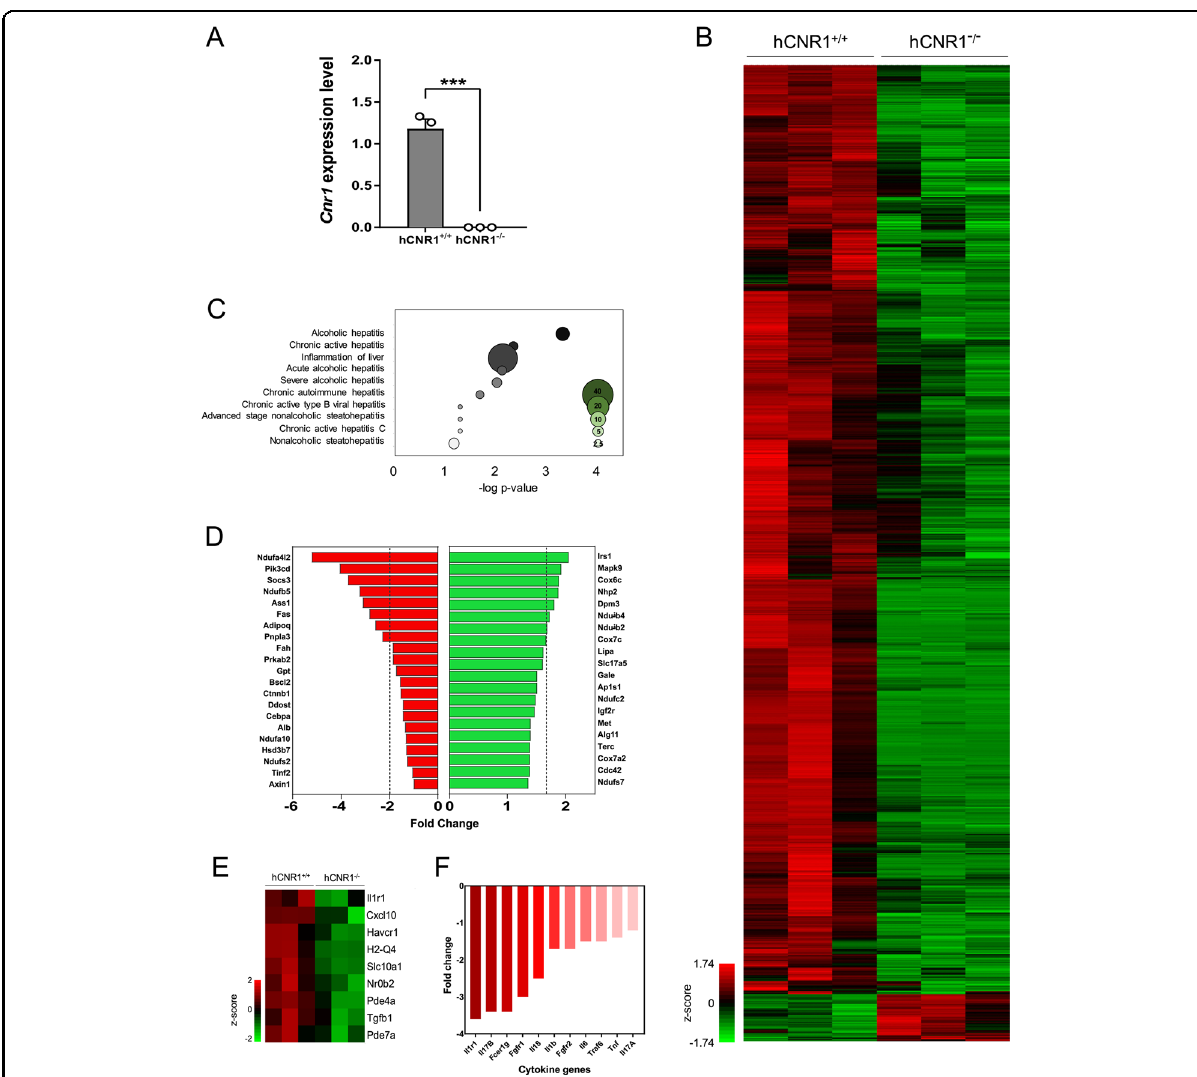
Fig. 1 Hepatic Cnr1 regulates liver disease-associated genes. Gene expression using RNA extracted from isolated hepatocytes of hCNR1 + / + and hCNR1 − / − mice ( n = 3). A CB1R mRNA ( Cnr1 ) expression in hepatocytes isolated from hCNR1 + / + and hCNR1 − / − mice. B Heat map of genome-wide expression changes by normalized z -score between − 1.74 and 1.74. C Gene ontology (GO) analysis on liver disease-related genes based on genome- wide expression changes by normalized z -score between − 1.74 and 1.74 depicted in B . Bubble sizes depict number of genes associated with hepatitis category. D Fold change of genes that are in fl ammation associated in hCNR − / − mice compared to hCNR + / + mice. E Fold change of genes that are liver-disease associated in hCNR − / − mice compared to hCNR1 + / + mice. Heat map showing z -score ( − 2.0 and 2.0) of the nine identi fi